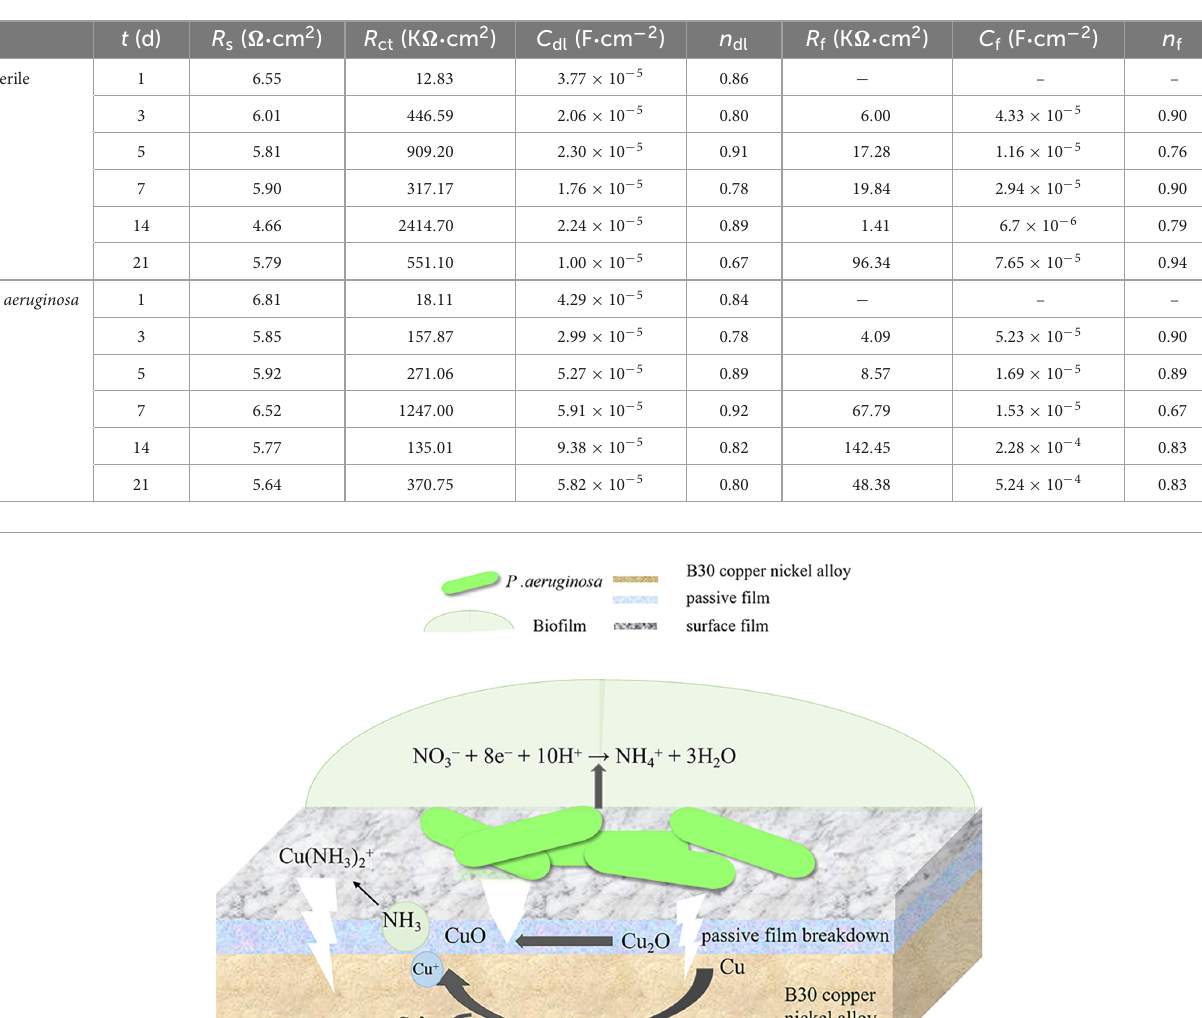
TABLE 3 Electrochemical impedance spectra fitting results for B30 copper–nickel alloy in different media.